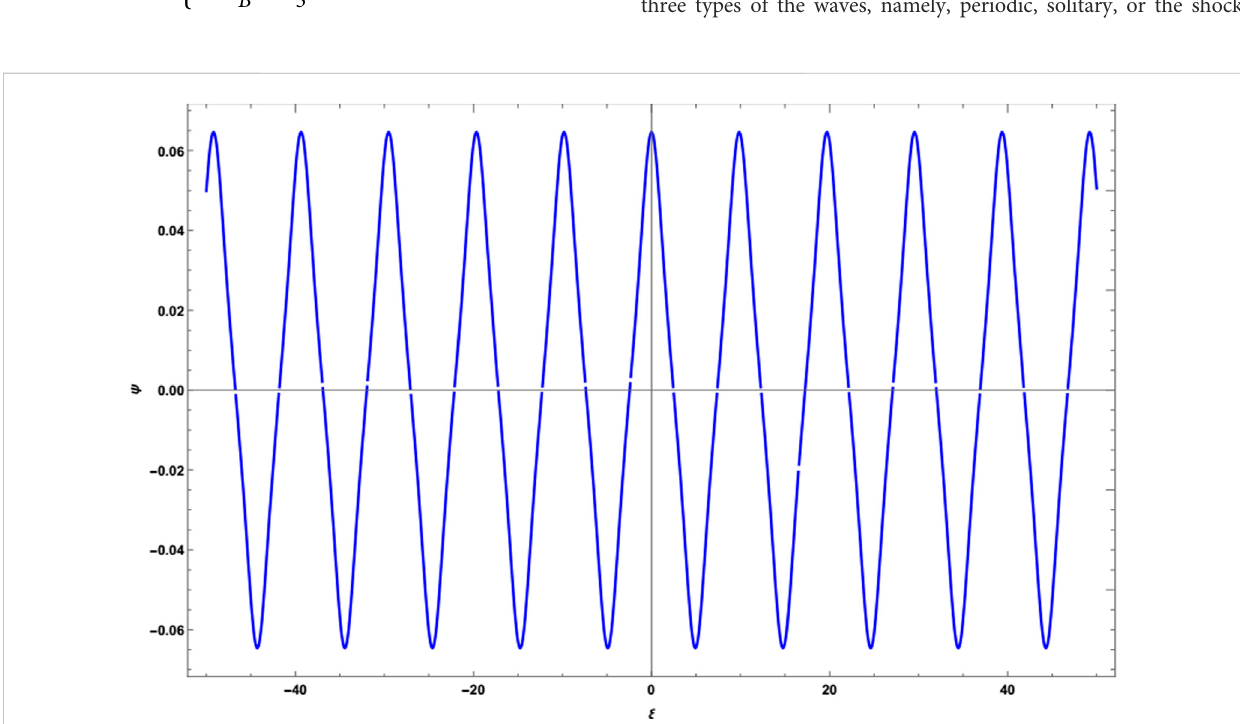
FIGURE 4 Periodic solution Cn for plasma parameters α =0.1, β =0.026, γ =0.7, δ =0.0, μ =0.1, ] =0.9, and m =0.2. Here, A < 0 and 0 < m <